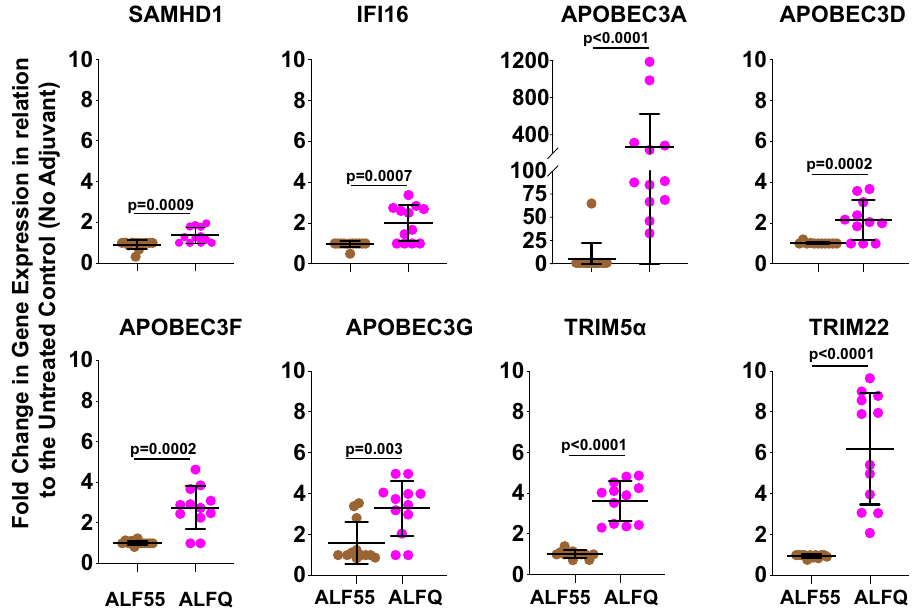
Figure 8. Expression of anti-viral genes is upregulated in ALFQ-treated MDM. Primary human monocytes were differentiated into MDM following in vitro culture with M-CSF media. At day 4 post-culture, the cells were treated with ALF55 or ALFQ for 24 h. Untreated MDM cultures served as controls. Cells were harvested, lysed and the gene expression levels of the cellular restriction factors were analyzed by qRT-PCR. The dot plots show fold-change in the expression levels of HIV-1 restriction genes for MDM that were pre-treated with ALF55 (brown circles) or ALFQ (magenta circles) in relation to the untreated (no adjuvant) MDM from triplicates wells of 4 donors. Statistical differences between the two groups were determined by two-tailed Mann–Whitney